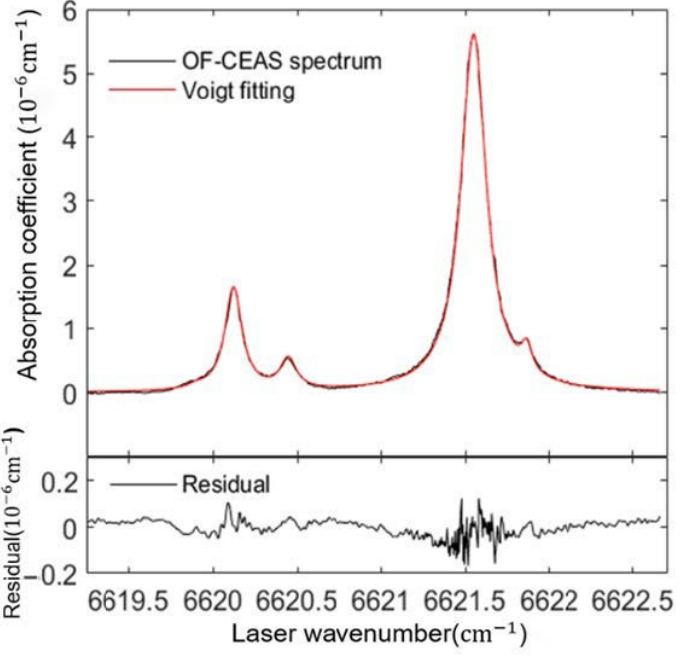
Figure 6. The cavity transmitted light signal of M2 (black). The simulated transmitted light of M2 (red) without etalon effect. The simulated results without etalon effect are based on Equation (3) and HITRAN 2020 (P= 1.0 atm, T = 25 °C). The bottom shows the residuals of the measured signal (black) and the ripple amplitude of M2.